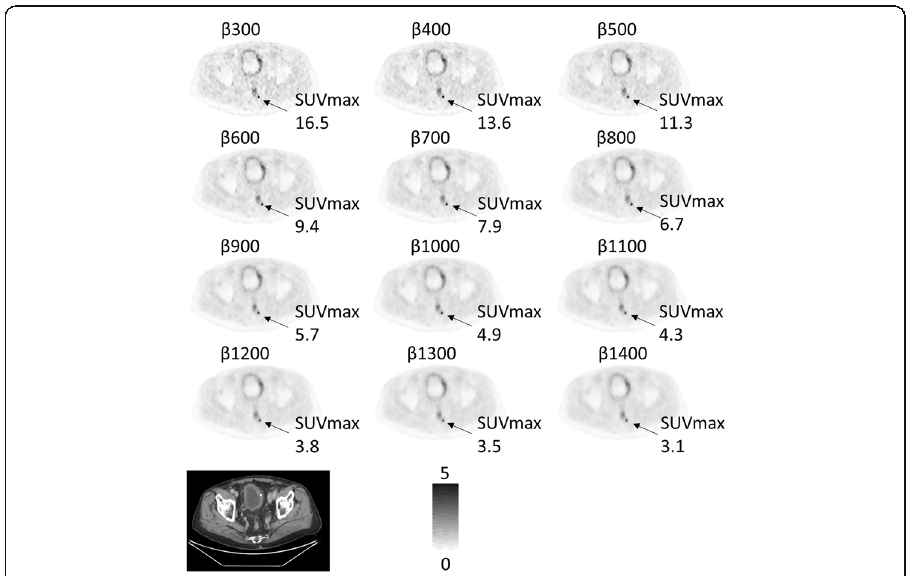
Fig. 3 Example of images with different β values for AT 8 . The SUVmax stated for a small perirectal lymph node